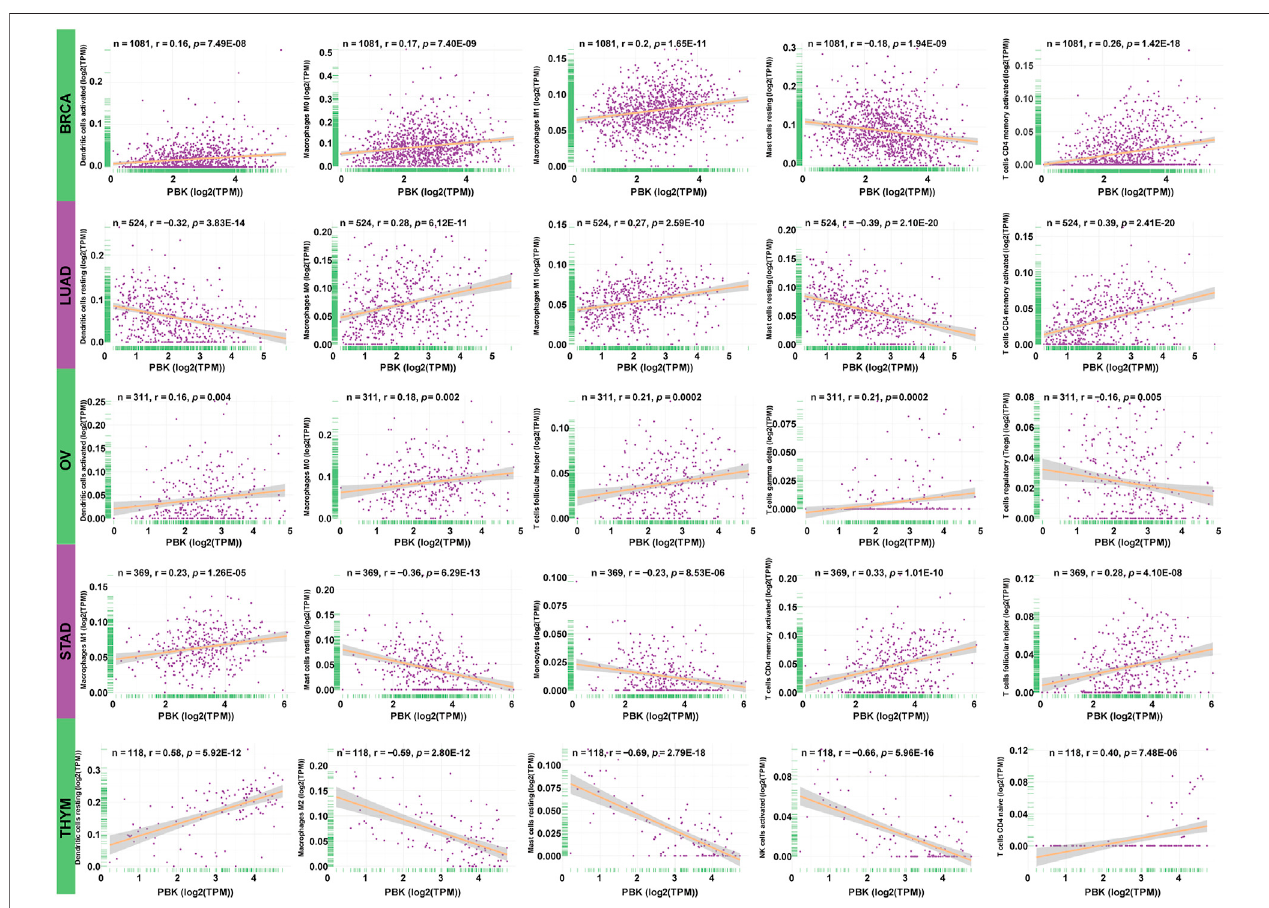
FIGURE 9 | | Association between PBK expression and tumor in fi ltration of different immune cells in fi ve tumor types.